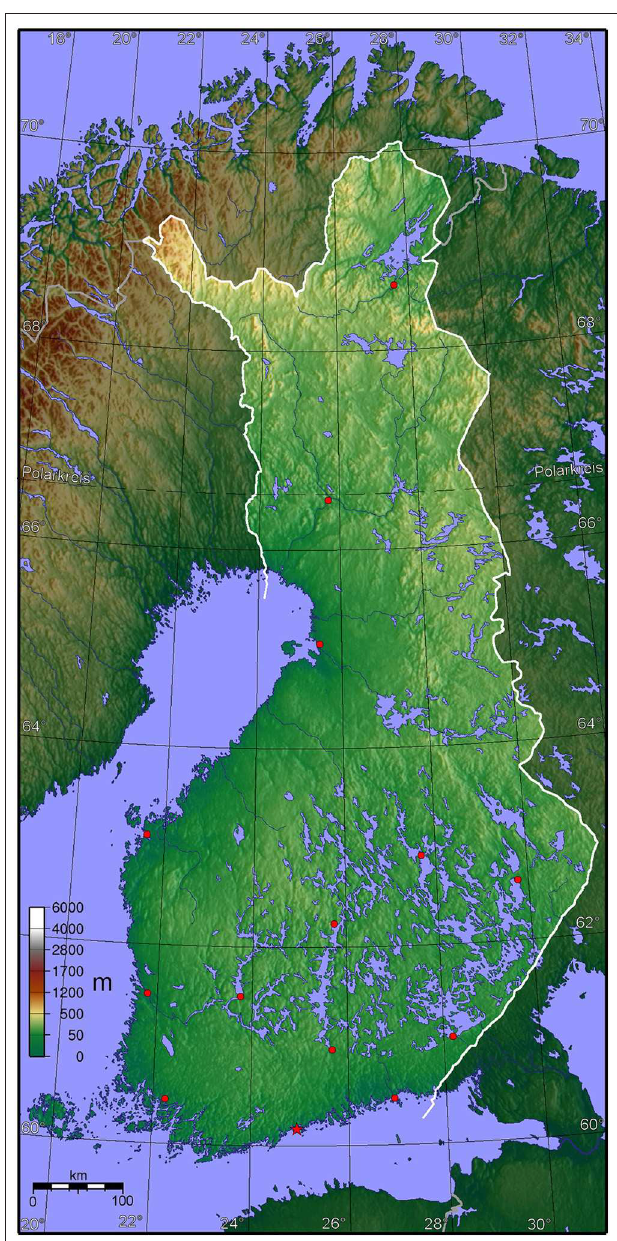
FIGURE 2 | Finland’s topography. Most of the country of Finland rises no more than 50m above sea level. Source: http://mapsof.net/uploads/static-maps/